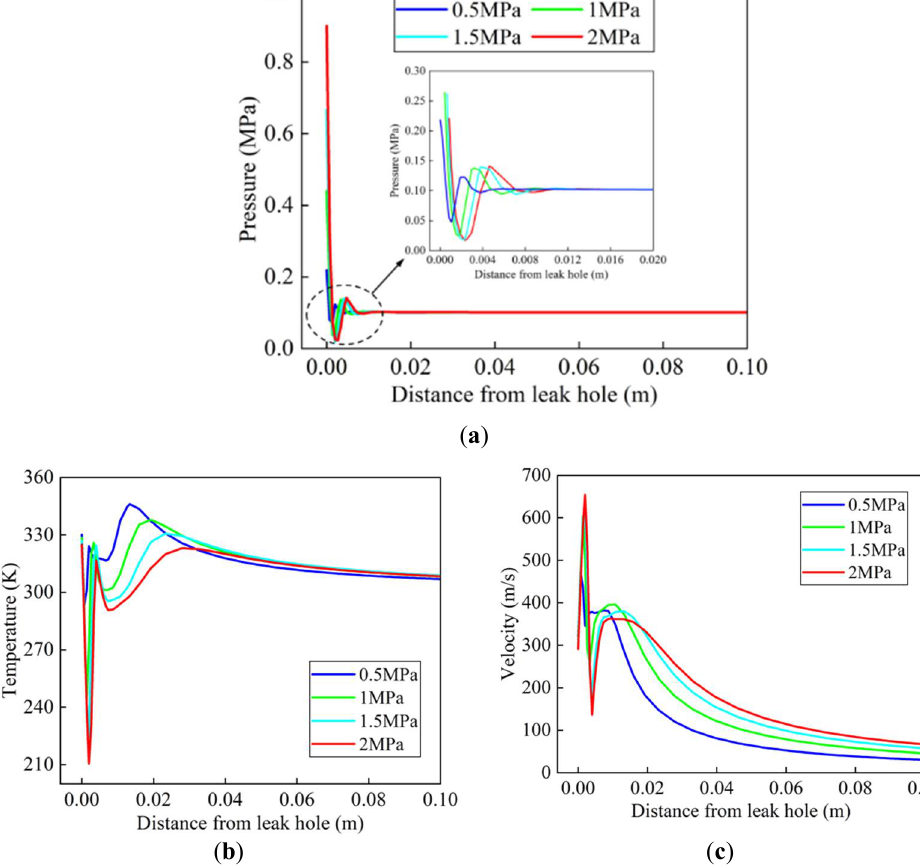
Figure 11. Field strength distribution of R290 on the jet axis under different initial leakage pressures: ( a ) pressure distribution; ( b ) temperature distribution; ( c ) velocity distribution.